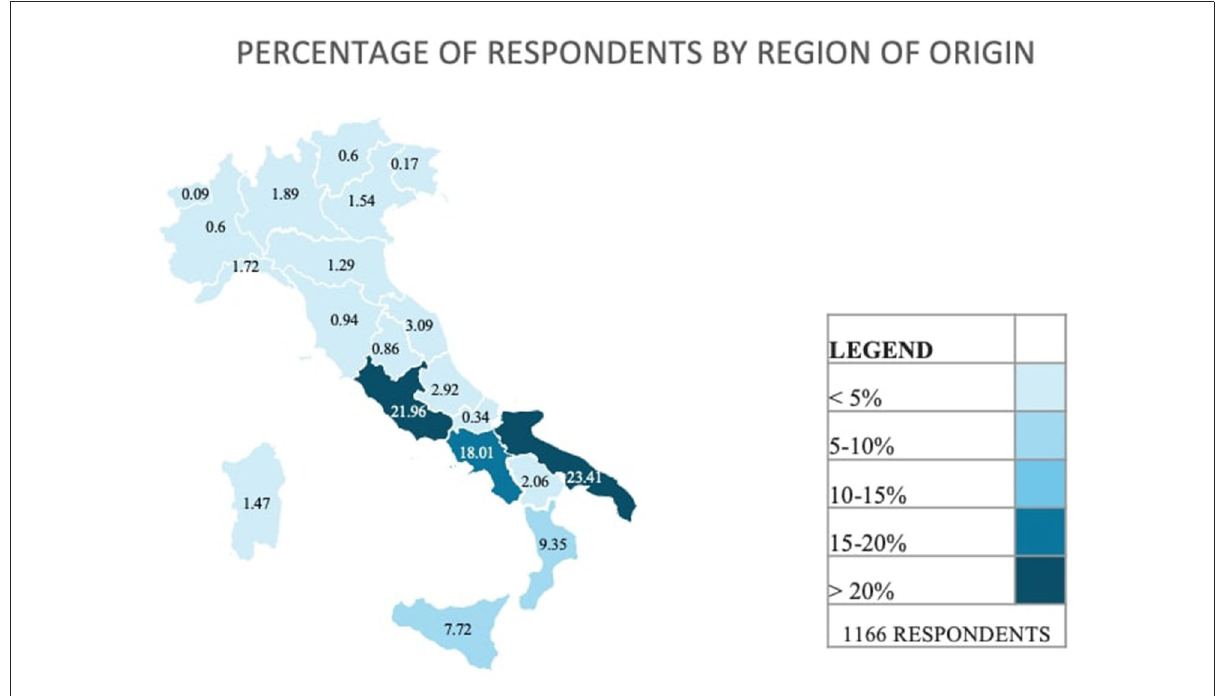
FIGURE1 Map of percentages of respondents by region of